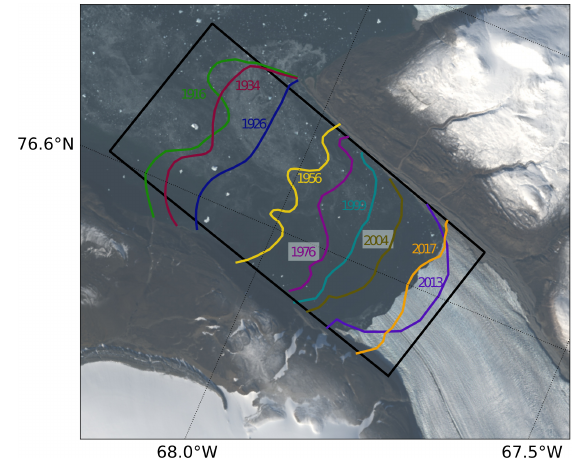
Figure B1. Digitized ice front positions and rectangle used for the estimation of the mean front position change. Background image: Landsat 8 scene of 2014 (USGS, 2019).